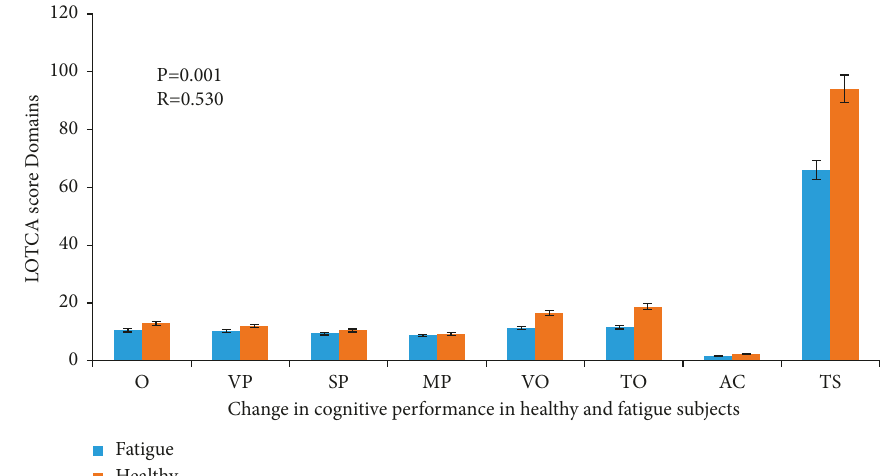
Figure 2: Differences in cognitive performance score domains (LOTCA-7-subset scores) in healthy and fatigued mature and older subjects. Data expressed as means SD. There was a significant reduction in the values of cognitive scores (LOTCA-7-subset scores) in cases with fatigue compared to normal healthy controls. For all estimated LOTCA-7-subset scores, cognitive decline was significant at R P 0.001 (fatigue versus control cases), respectively. O: orientation; VP: visual perception; SP: spatial perception; MP: motor praxis; VO: ± (cid:31) vasomotor organization; TO: thinking operations; AC: attention and concentration; TS: total LOTCA score.